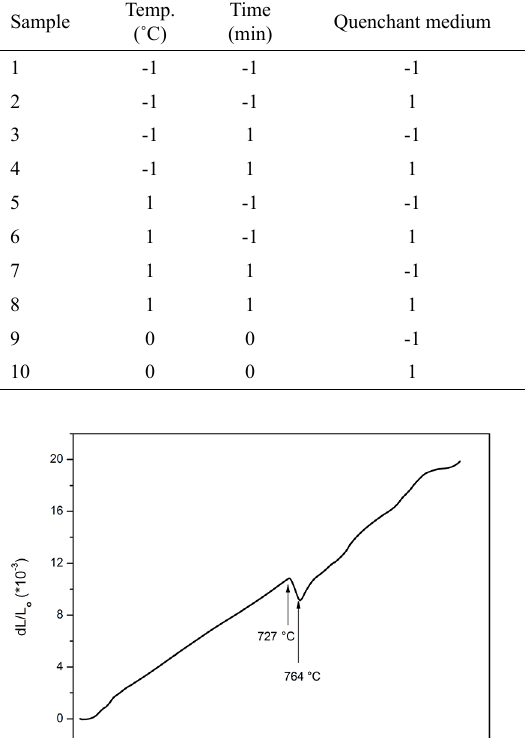
Table 3. Design of experiments plan. Sample